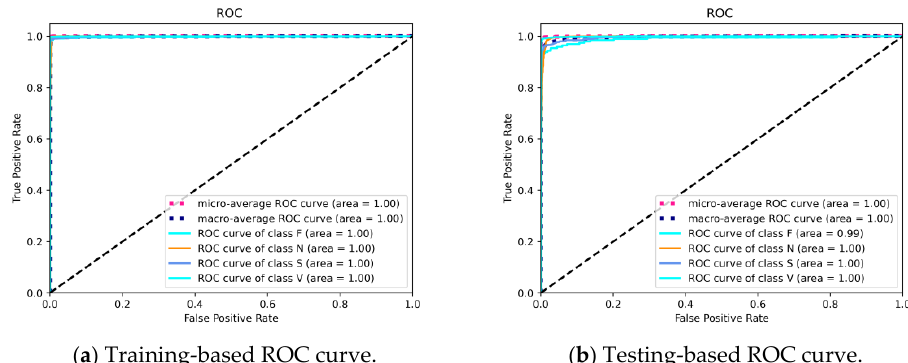
Figure 7. ROC curve of the 1D-CNN model for arrhythmia categorization. Micro-average and macro-average are two ways of summarizing the information of